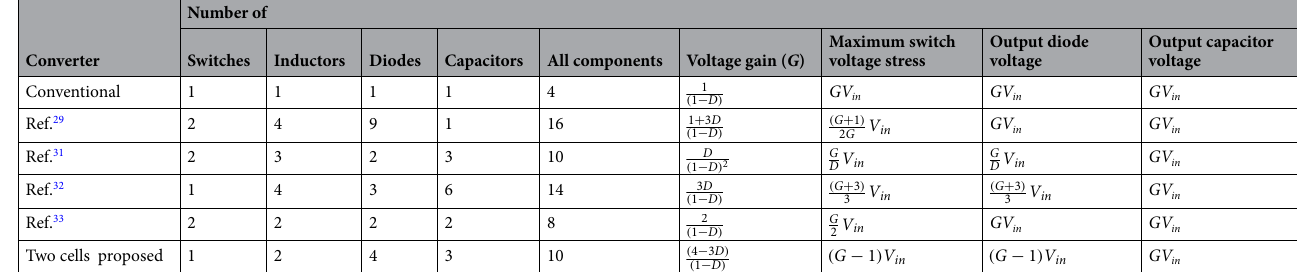
Table 3. Comparison between the proposed converter and recent converter